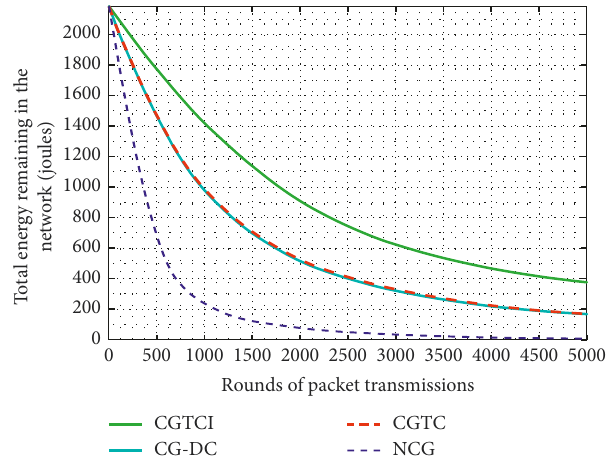
Figure 8: The trend of total energy remaining in the network.